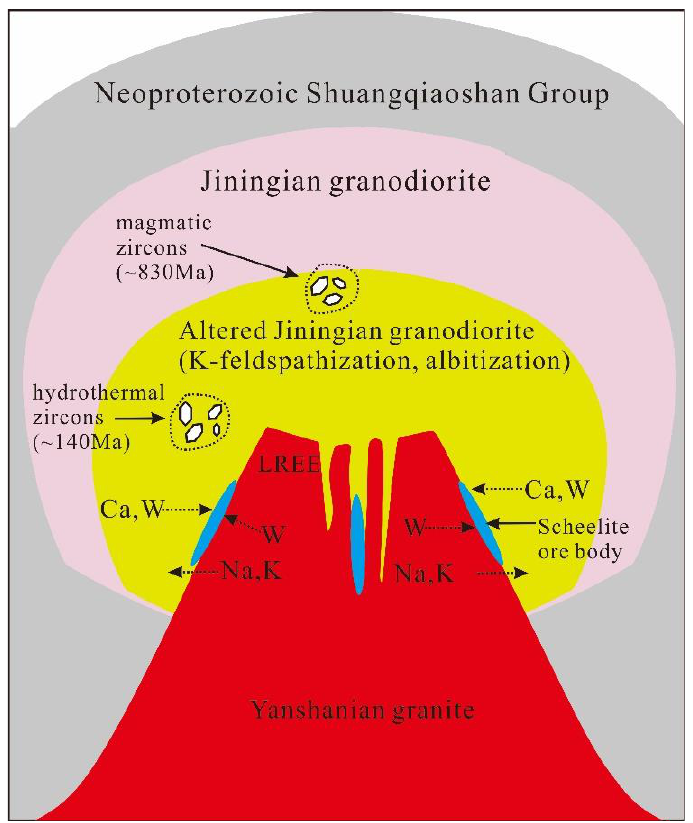
Figure 12. Mineralization model for porphyry scheelite in the Dahutang deposit (modified after